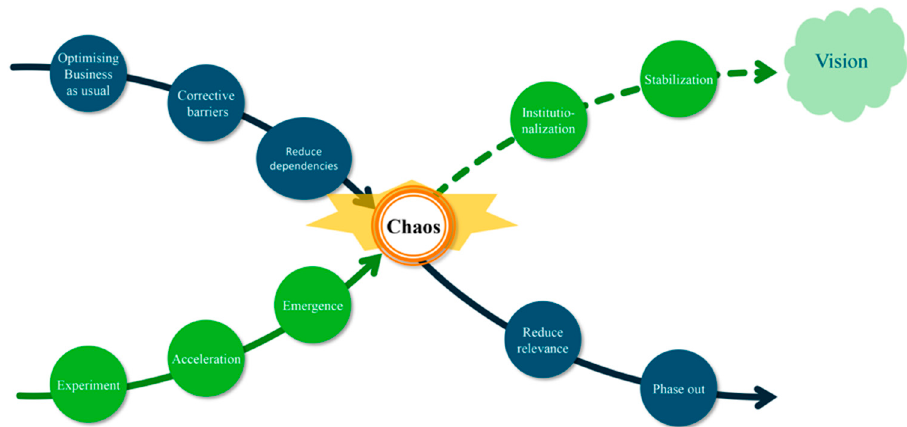
Figure 1. The X-curve transition cross (adapted after Visser, Keesstra, Maas and de Cleen Figure 1. The X ‐ curve transition cross (adapted after Visser, Keesstra, Maas and de Cleen [8] ).